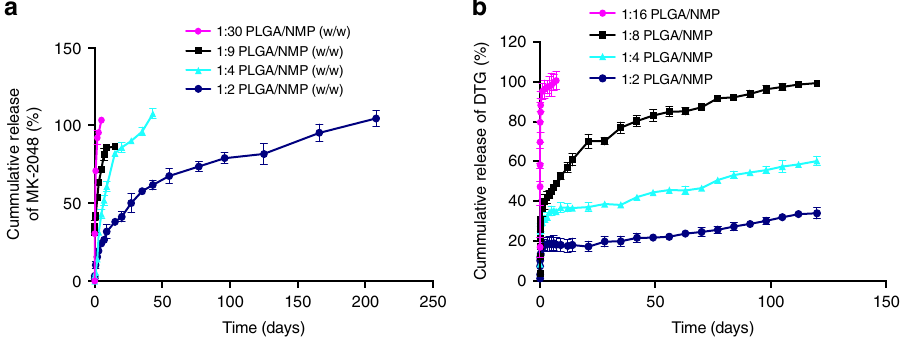
Fig. 4 In vitro release kinetics. Cumulative release of MK-2048 over the course of 220 days ( a ) and DTG over the course of 120 days ( b ) from ISFI formulations containing varying ratios of PLGA to NMP. Drug release studies were carried out under sink conditions in 0.01 M PBS pH 7.4 + 2% solutol at 37 °C. Drug concentration was maintained constant across all PLGA/NMP ratios for each drug. All error bars are equivalent (s.d. positive and negative values) and represent standard deviation with n = 3. Release kinetics were signi fi cantly different across various PLGA/NMP ratios for both MK-2048 and DTG-ISFIs and across drugs at the same PLGA/NMP ratio (1:2 and 1:4 w/w PLGA/NMP) (Kruskal – Wallis test, p < 0.0001). Source data are provided as a Source Data fi